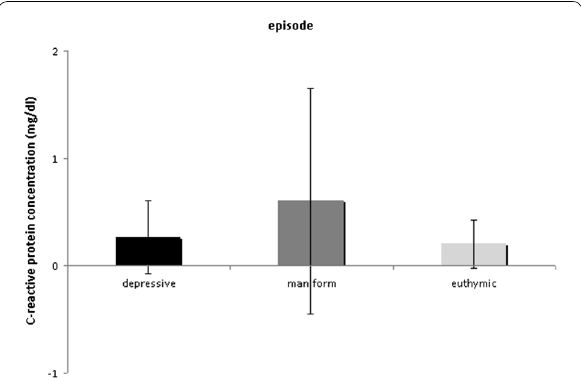
Fig. 1 Measured levels of C‑reactive protein levels in bipolar patients in different episodes. Manic patients (n higher C‑reactive protein levels as compared to euthymic (n depressed patients (n levels are given as mean values